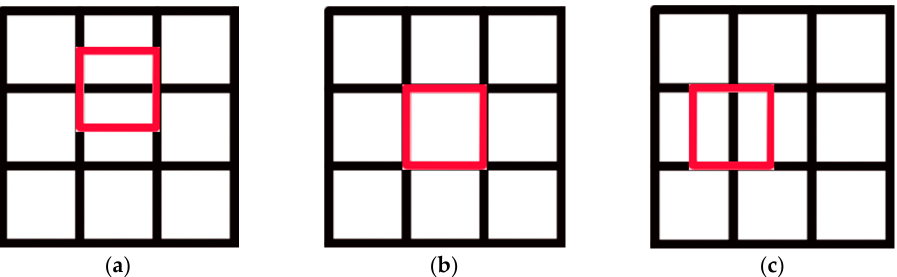
Figure 2. Schematic diagram of the constraints in the grid map workspace: ( a – c ) the three states of the robot working in the grid map workspace.